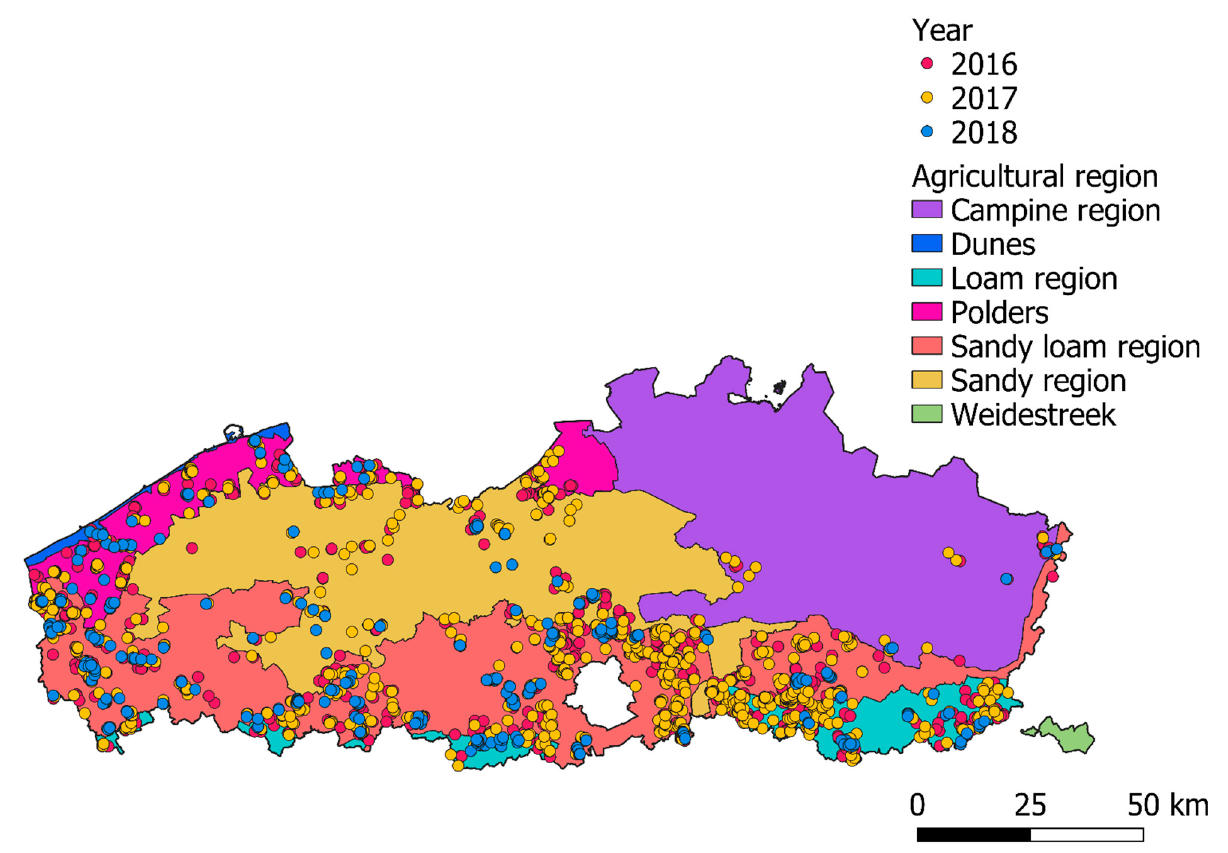
Figure 1. Location of the studied winter wheat fields in northern Belgium from 2016 ( n = 666), 2017 ( n = 609) and 2018 ( n = 210). The seven agricultural regions of northern Belgium are also visualized.